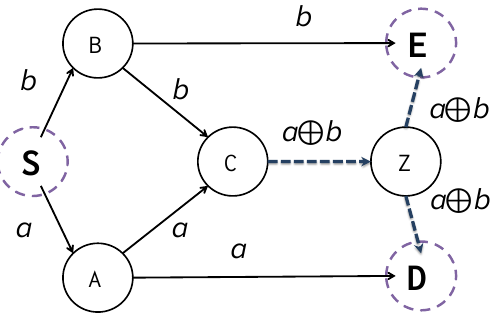
Figure 2. Advantage of using network